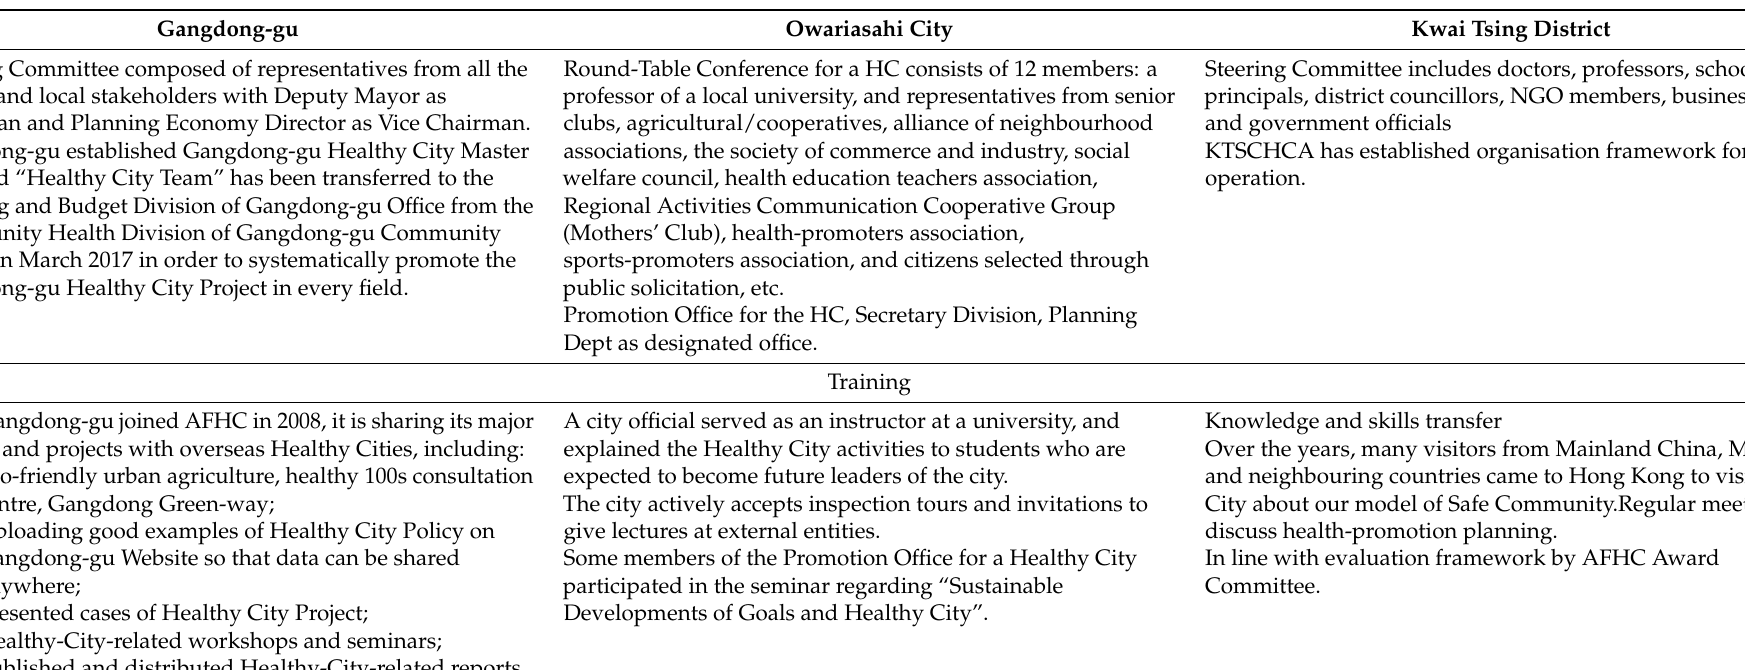
Table 6. Infrastructure and Intersectoral and